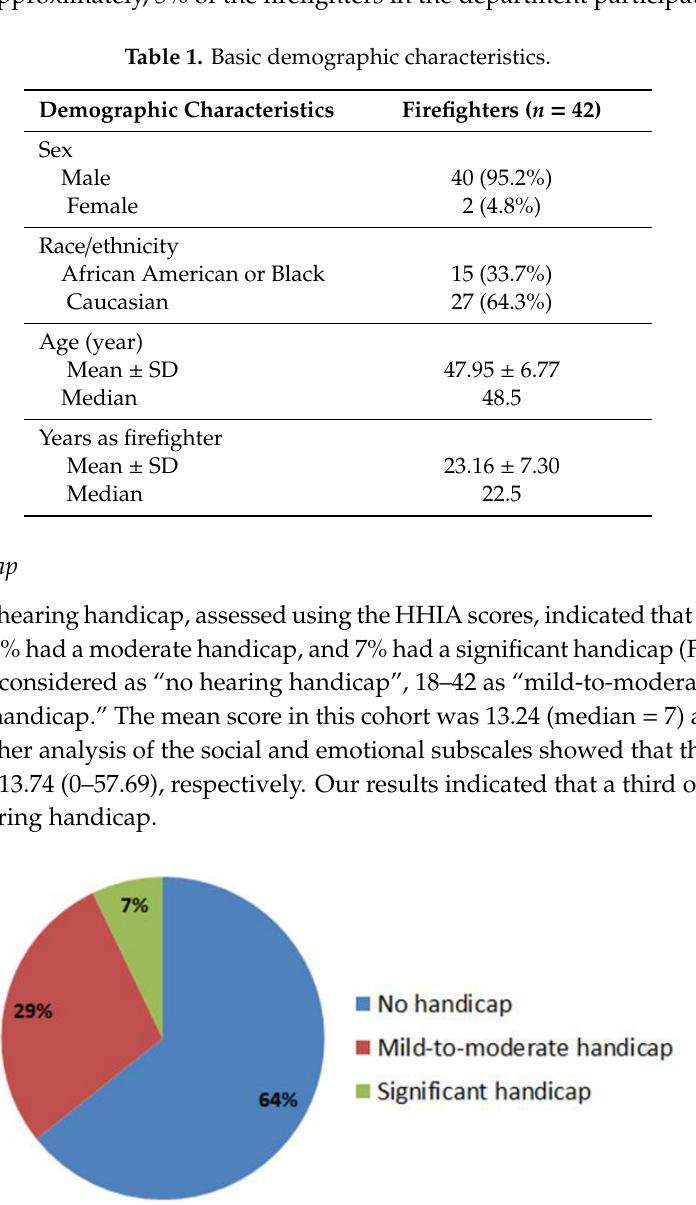
Figure 1. Self-perceived hearing handicap in firefighters. The hearing handicap inventory for adults (HHIA) scores for 27 firefighters were in the 0–17 range, suggesting no hearing handicap. However, the HHIA scores for 12 firefighters were in the 18–42 range, suggesting mild-to-moderate handicap and the HHIA scores for 3 firefighters were above, 42 suggesting significant hearing handicap.